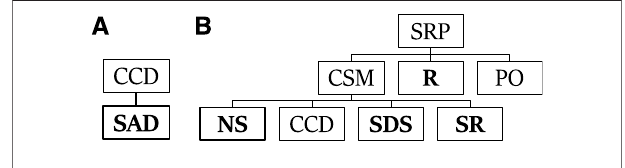
FIGURE 3 | Leftmost deriving trees for SRP (B) and CCD (A) .